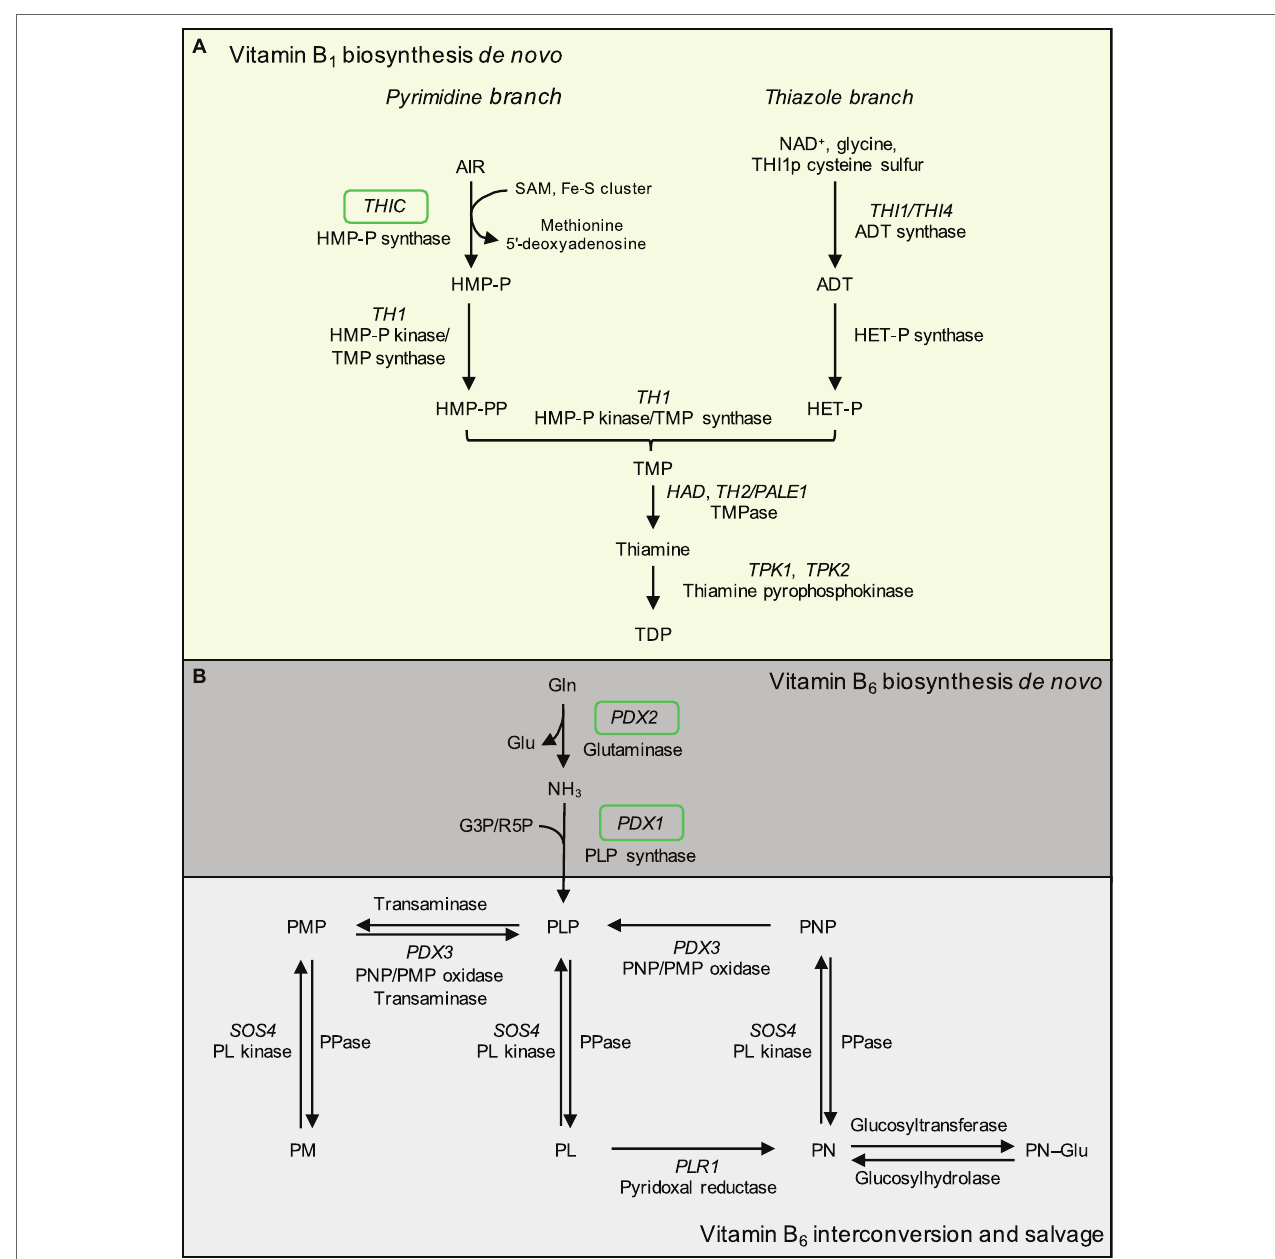
FIGURE 1 | Biosynthesis de novo of vitamin B 1 and B 6 in plants based on Arabidopsis. (A) Vitamin B 1 biosynthesis de novo is predominantly localized to the chloroplast and comprises formation of pyrimidine and thiazole heterocycles linked by a methylene bridge. The pyrimidine moiety of vitamin B 1 is supplied via conversion of 5-amino-imidazole ribotide (AIR) into 4-amino-5-hydroxymethyl-2-pyrimidine phosphate (HMP-P) by HMP-P synthase (encoded by THIC ) in an iron- sulfur cluster and SAM-dependent reaction, with the release of methionine and a 5 ′ -deoxyadenosine radical. Next, HMP-P is phosphorylated to HMP-PP by the bifunctional HMP-P kinase/TMP synthase (encoded by THIAMIN REQUIRING 1, TH1 ). The thiazole moiety of vitamin B 1 is produced from nicotinamide adenine dinucleotide (NAD + ), glycine, and a sulfur atom donated from a conserved cysteine residue from the single-turnover enzyme ADT synthase/THI4 (encoded by THI1 in plants, THI4 in yeast) to produce adenosine diphosphate thiazole (ADT). ADT is converted to hydroxyethylthiazole phosphate (HET-P) by HET-P synthase activity (loci encoding this activity currently unconfirmed). HET-P and HMP-PP are condensed by TMP synthase activity of TH1 to form thiamine monophosphate (TMP). TMP is dephosphorylated by TMP phosphatases (TMPase) including TH2/PALE1 (THIAMIN REQUIRING 2/PALE GREEN 1) and HALOACID DEHALOGENASE (HAD), forming free thiamine. The cofactor vitamer thiamine diphosphate (TDP) is generated by diphosphorylation of free thiamine at the hydroxyl position by thiamine pyrophosphokinases (encoded by At TPK1–2 , Os TPK1–3 ). (B) Vitamin B 6 biosynthesis de novo is localized to the cytosol to form the cofactor vitamer pyridoxal 5 ′ -phosphate (PLP). PDX2 is a glutaminase that yields glutamate and ammonia, the latter is used by PLP synthase (PDX1, encoded by PDX1.1 – 1.3 in Arabidopsis and PDX1.3a – c in rice) to form PLP with the addition of either ribose 5-phosphate (R5P) or glyceraldehyde 3-phosphate (G3P). B 6 vitamers are interconverted in